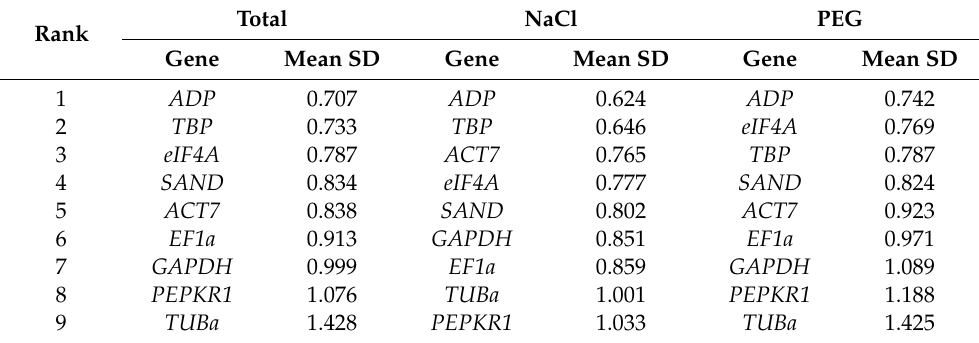
Table 2. Candidate reference gene ranking according to deltaCt method. The lower the mean standard deviation (mean SD) value the more stable is the gene’s expression in tested samples. Analysis was performed for NaCl treated samples (NaCl), PEG treated samples (PEG) and all samples combined together (Total).